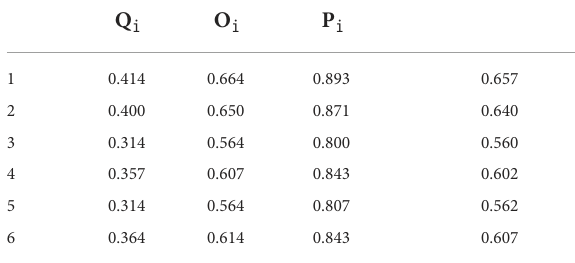
TABLE 7 Defuzzification of O ratings in Fuzzy-FMEA.